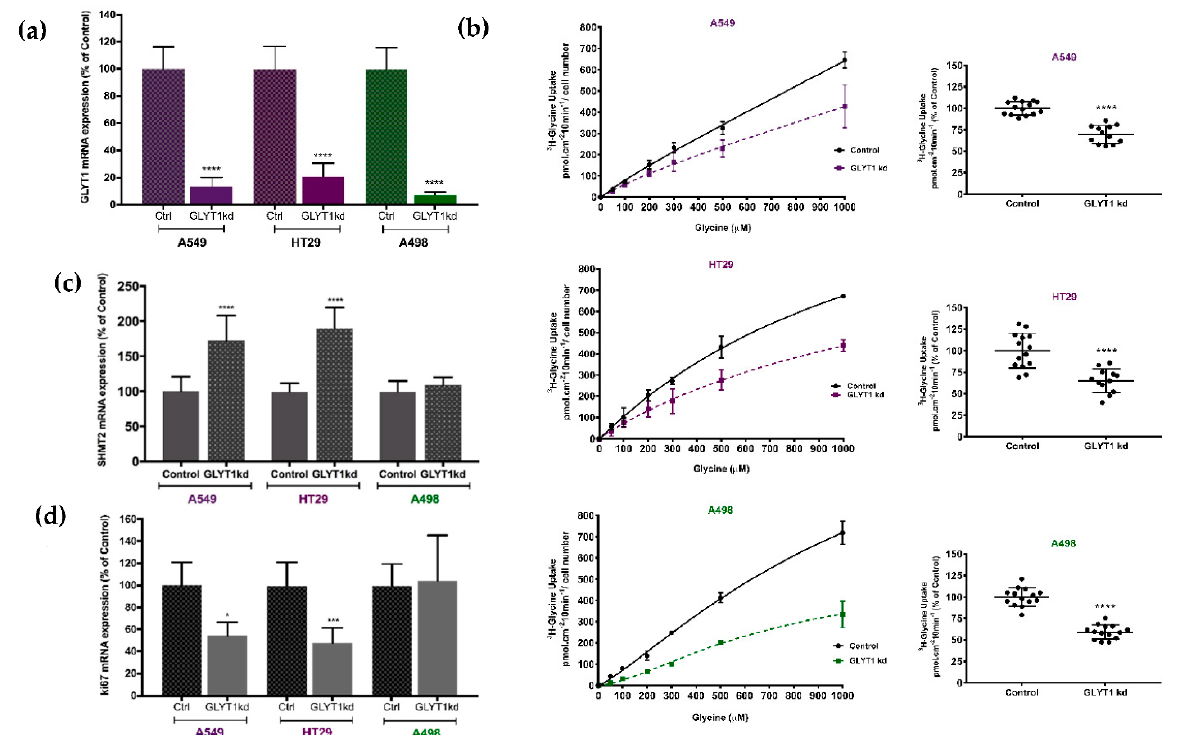
Figure 1. GLYT1 knockdown efficiency and effect on proliferation marker ki67. ( a ) Following GLYT1kd there was a significant reduction of GLYT1 mRNA abundance for all cells analysed when compared to control groups. ( b ) GLYT1 downregulation significantly reduced total glycine uptake measured by [2-3H]-glycine uptake analysis for all tumour cell lines in this study. ( c ) qPCR analysis showing upregulation of SHMT2 mRNA expression following GLYT1kd in comparison to control. ( d ) qPCR analysis of the influence of GLYT1kd on the proliferation marker ki67 mRNA expression in comparison to control. Statistical analysis comparing control and GLYT1kd was performed by unpaired t-test considering significance at p < 0.05 (*), p < 0.001 (***), and p < 0.0001 (****).